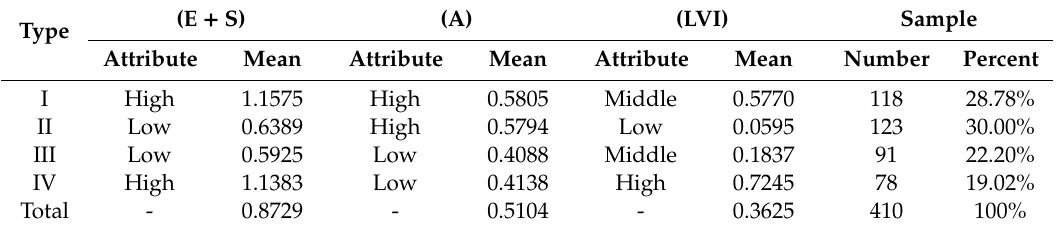
Table 4. Types of livelihood vulnerability of employees in sample relocation